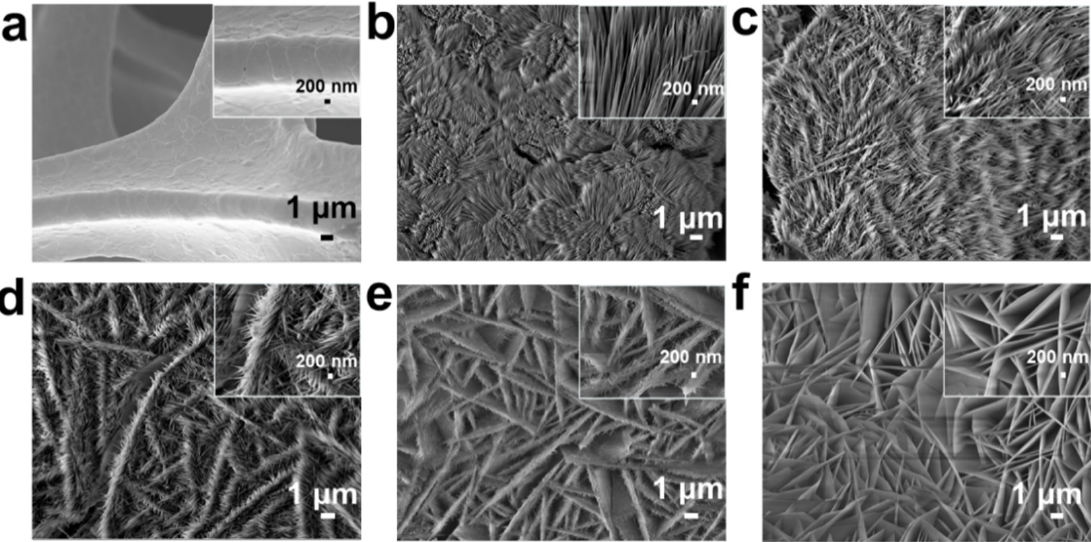
Figure 2. SEM images of ( a ) pre-treated Ni foam, ( b ) Co-hydroxide NA/NF, ( c ) CoNi-hydroxide NA/NF-1, ( d ) CoNi-hydroxide NA/NF-2, ( e ) CoNi-hydroxide NA/NF-3 and ( f ) Ni-hydroxide NA/NF.